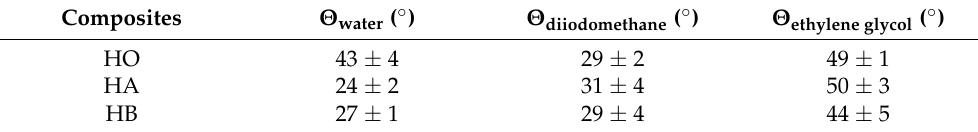
Table 4. Contact angles of the tested films for water, diiodomethane, and ethylene glycol. Composites